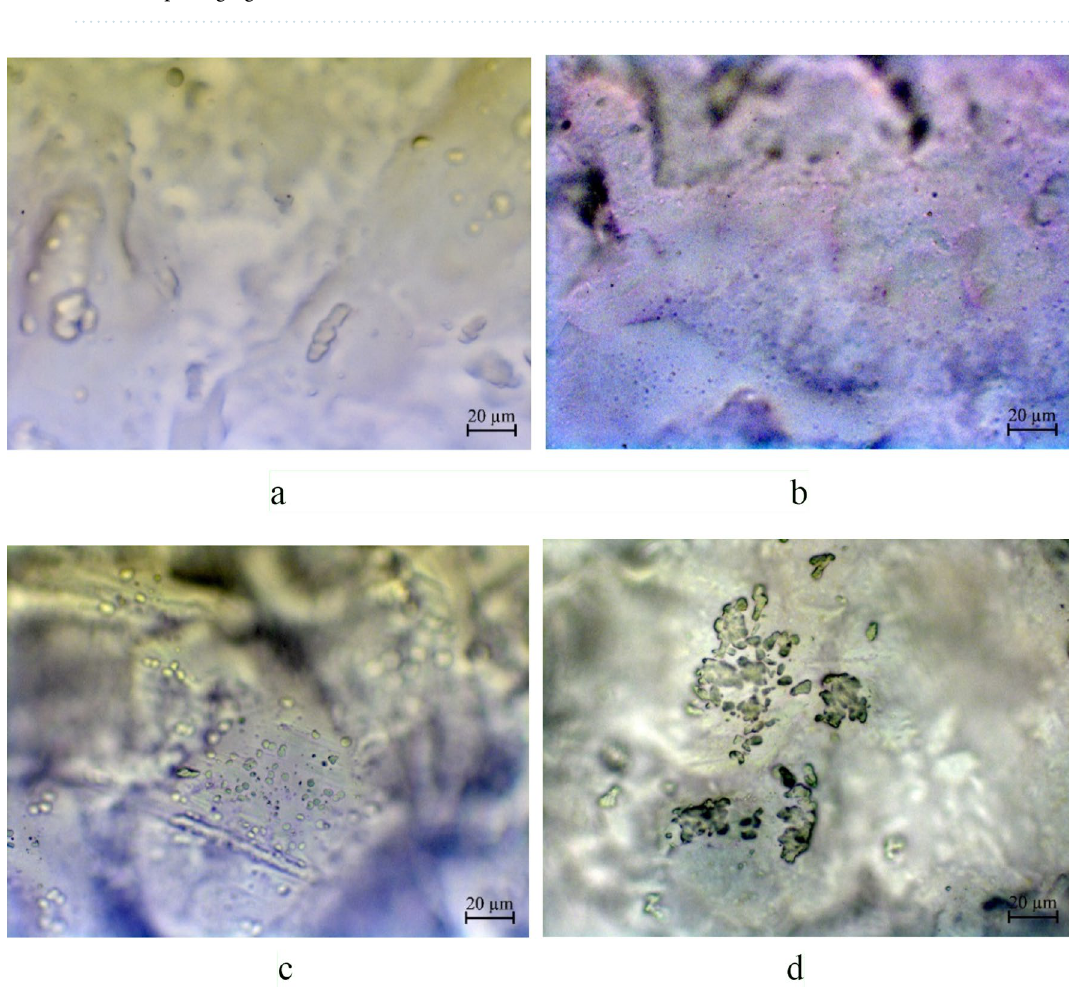
Figure 20. Micrographs of samples of methylcellulose films modified with CuO nanoparticles: ( a ) control, ( b ) 0,2%, ( c ) 0,4%, ( d )